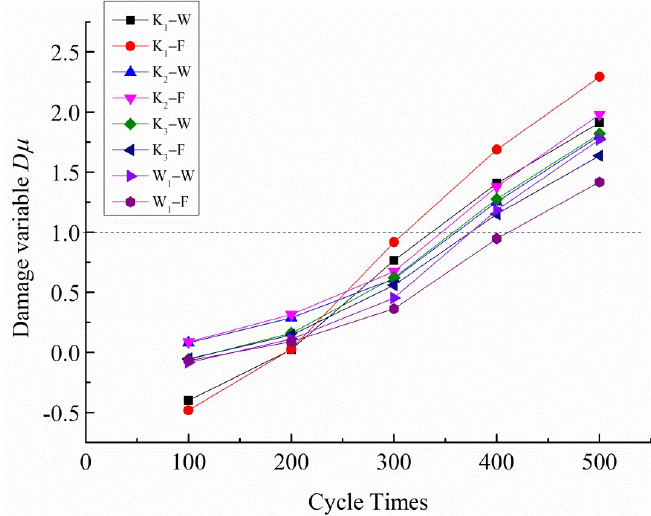
Figure 8. Curves of the damage variable D u and cycle number.